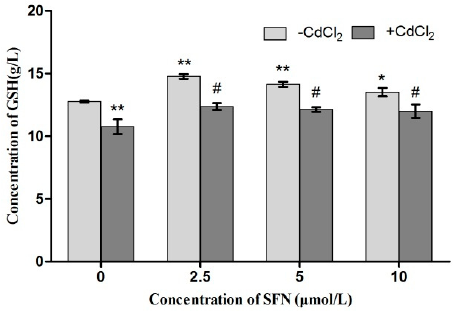
Figure 12. Content of GSH in TM3. * and ** represent a significant and an extremely significant difference, respectively, compared with the control group. # represent a significant difference compared with the Cd group.